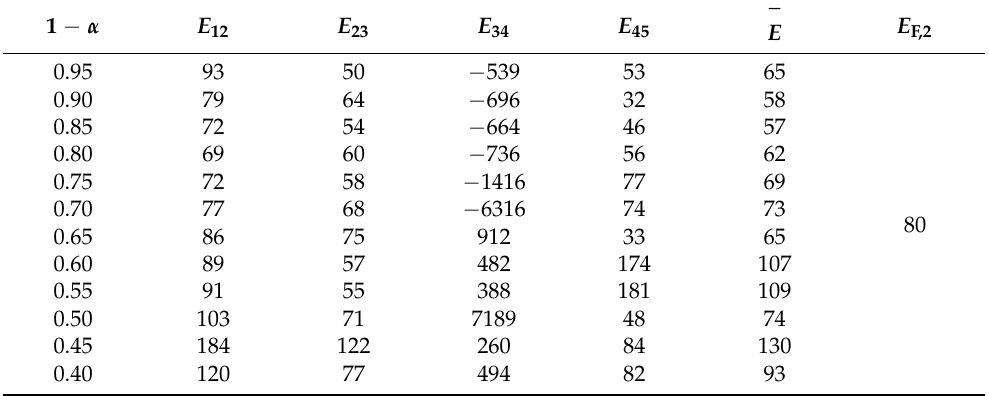
Table 2. The activation energy E F,2 of urea decomposition from two-interval method (Unit: kJ/mol). 1 −